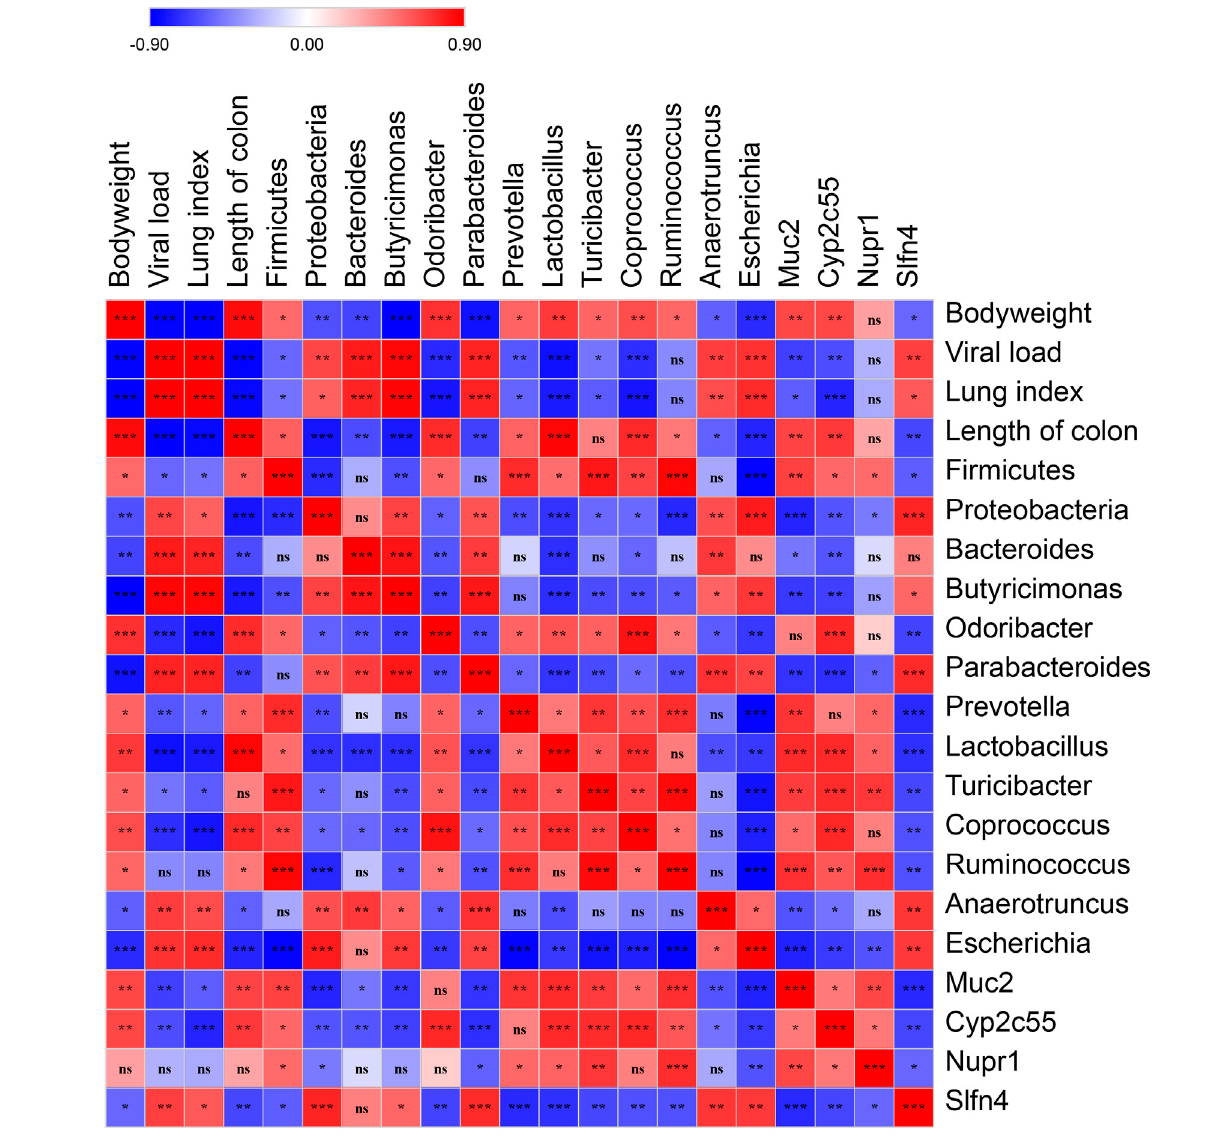
Frontiers in Pharmacology |